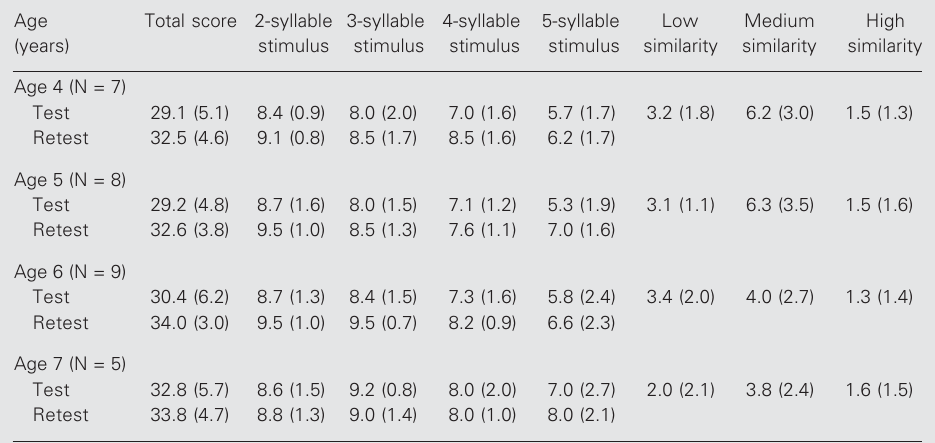
Table 1. Test-retest reliability study of age and wordlikeness effect (N = 29).